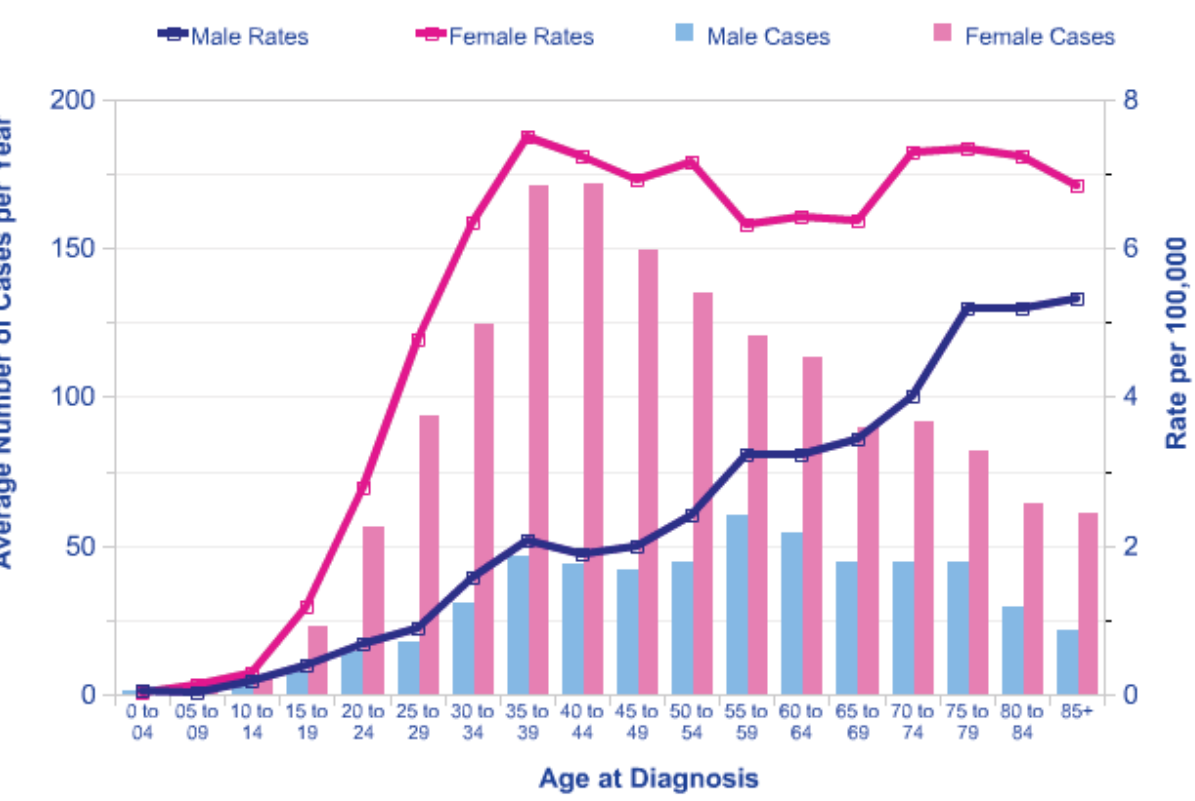
Figure 1. Thyroid cancer Average Number of New Cases per Year and Age-Specific Incidence Rates, UK, 2006–2008. Data available from http://info.cancerresearchuk.org/